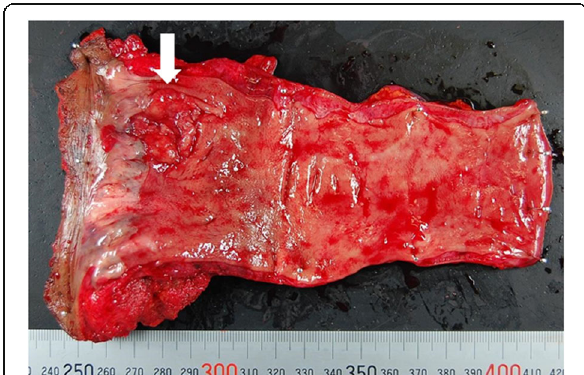
Fig. 1 A resected specimen is shown. A tumor located on the dentate